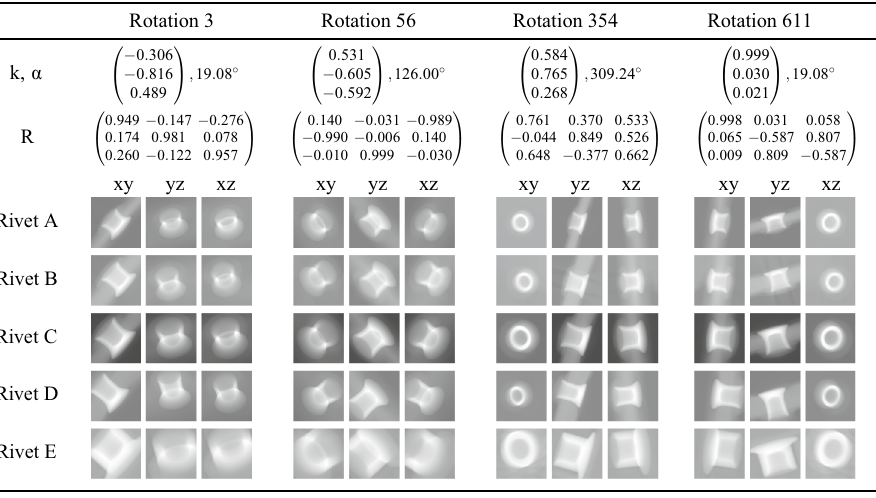
Table 5 Exemplary rotations from the data set. Images xy, yz, and xz serve as input to a convolutional neural network and the rota- tion matrices R serve as the labels. The Rodrigues parameters k and a are the foundation for generating a uniformly distributed data set of rotations. They were used to generate the rotation matrices.